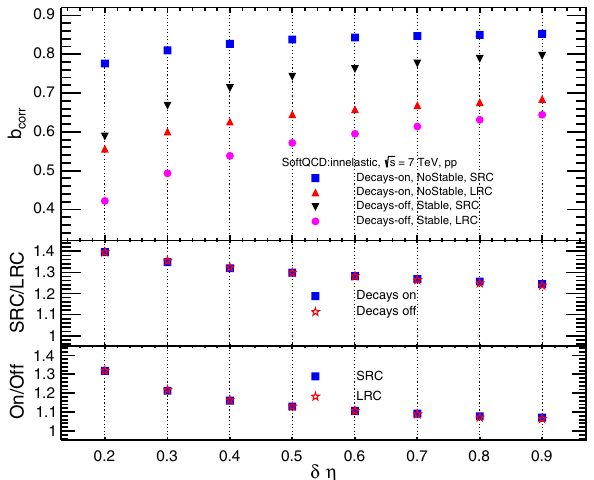
Fig. 1 Correlations with and without weak decays for short and long range correlations. The middle panel shows the ratio of b Corr with to without weak decays. Bottom panel shows the ratio of b Corr for central to forward pseudorapidity multiplicity distributions